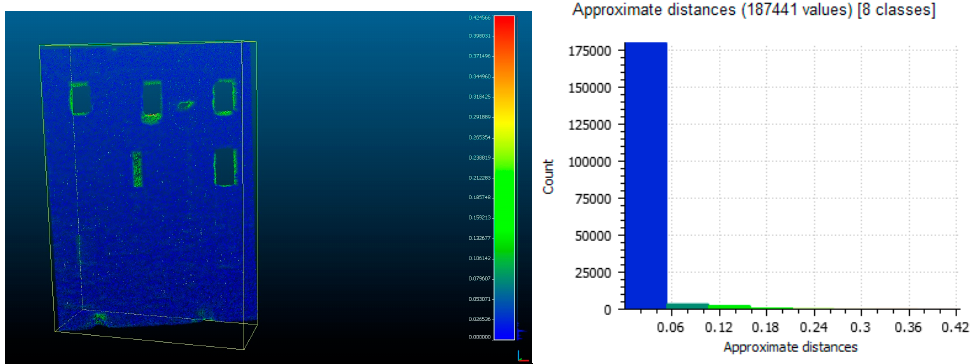
Figure 27. Discrepancy map and histogram between the TLS cloud and UAV Nadir + Oblique in Photoscan. ISPRS Int. J. Geo-Inf. 2017 , 6 , 393 23 of 26